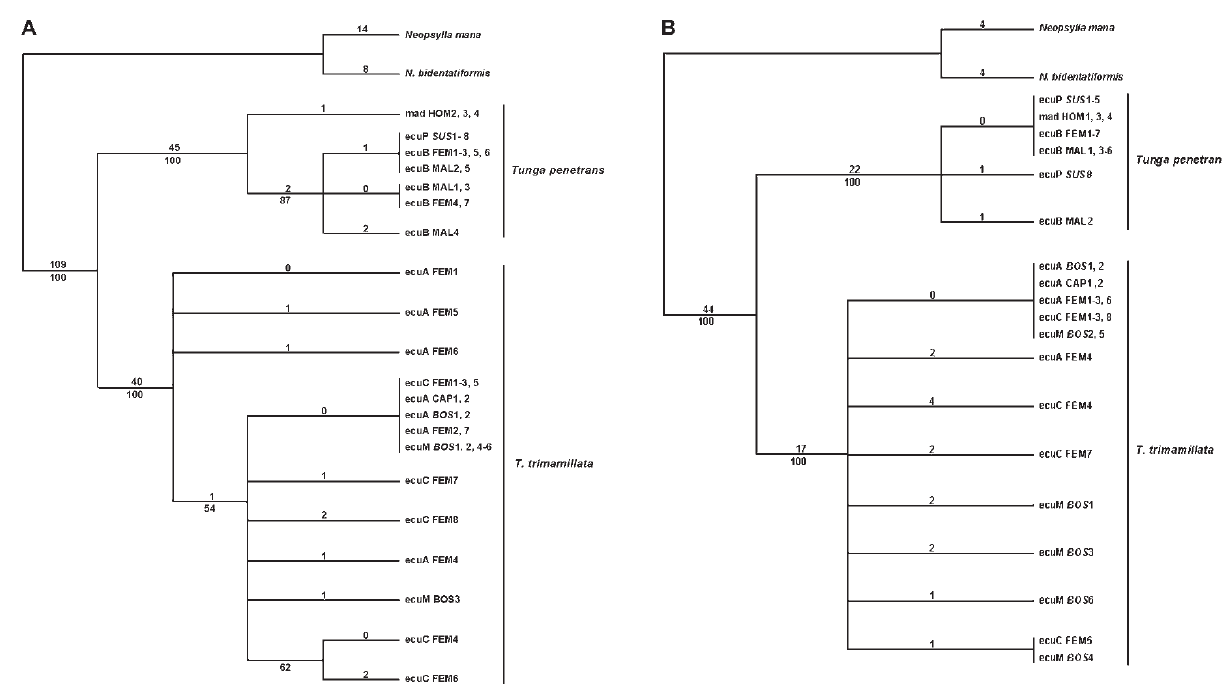
1. – Maximum Parsimony bootstrap consensus dendrograms computed on: A) COII haplotypes (TL = 233; CI = 0.974; HI = 0.026); B) 16S haplotypes (TL = 107; CI = 0.981; HI = 0.019). Numbers above and below branches indicate mutational steps and bootstrap per- centages, respectively. Acronyms are as in Table I.